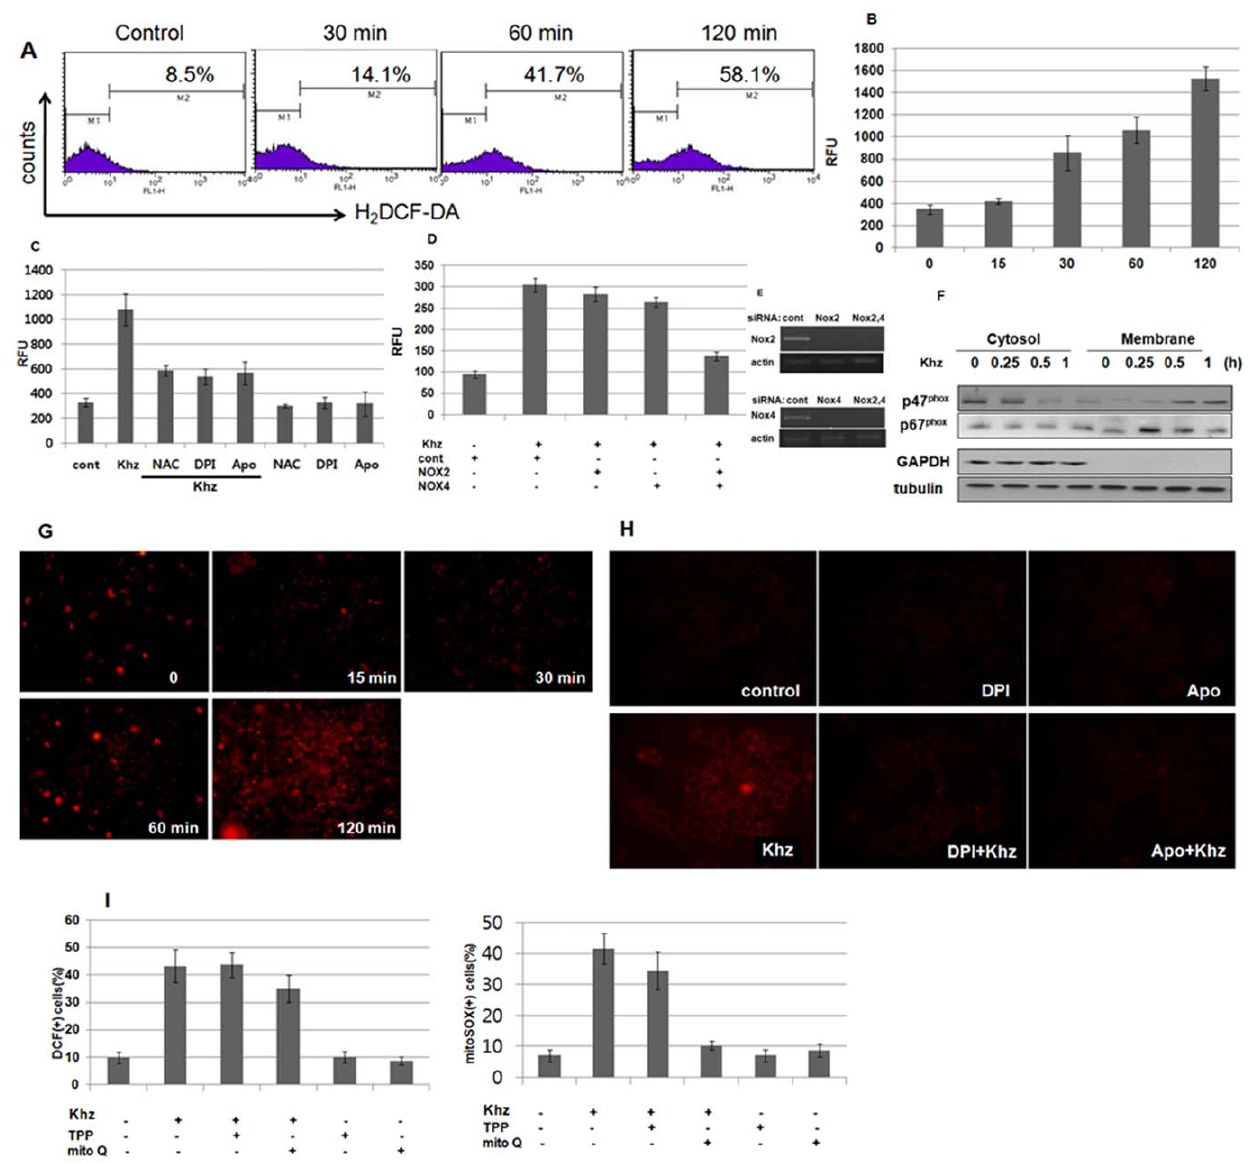
Figure 4. Khz triggers cytoplasmic and mitochondrial ROS generation. (A) HepG2 cells were loaded with H 2 DCF-DA and treated with Khz (diluted 1:2), and the cytoplasmic ROS levels were assessed by flow cytometry. Data are representative of more than 3 experiments. (B) Intracellular ROS levels in HepG2 cells treated with Khz (diluted 1:2) were analyzed using an Amplex Red hydrogen peroxide assay. Data represent mean 6 SD. (C) Cells were pretreated with NAC (5 mM), DPI (10 m M), or apocynin (Apo; 300 m M) for 1 h. Intracellular ROS levels in HepG2 cells were analyzed 30 min after Khz treatment using the Amplex Red hydrogen peroxide assay. (D–E) HepG2 cells were transfected with siRNAs targeting Nox2 and Nox4. After 48 h, the cells were treated with Khz, and ROS generation was measured after 60 min using the Amplex Red hydrogen peroxide assay. Data represent mean 6 SD. (E). Silencing of Nox2 and Nox4 mRNA expression by siRNA transfection was assessed by RT-PCR. (F) HepG2 cells were treated with Khz, and the membrane and cytosol fractions were separated using the Compartmental Protein Extraction kit (Millipore). The expression of the p47